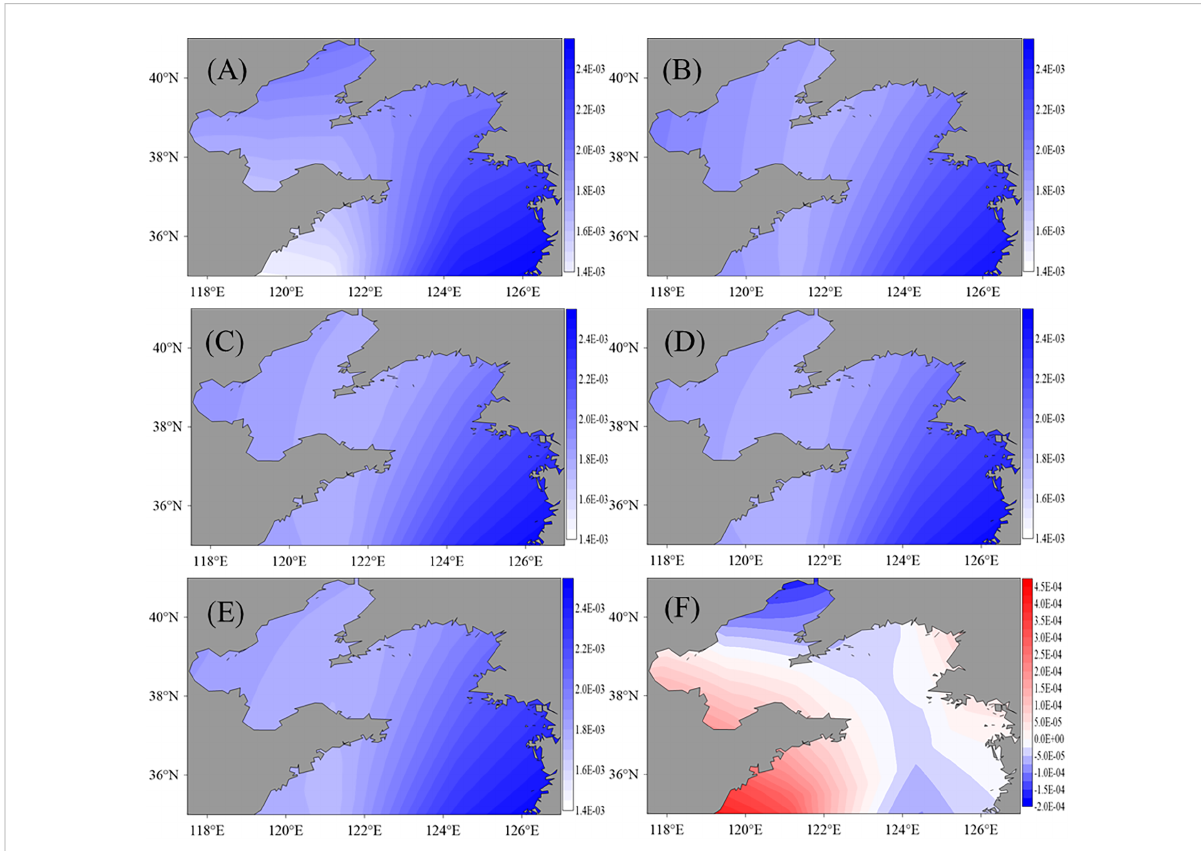
FIGURE 4 Distributions of the true BFCs (A) and that of experiment results with the 1°×1° (B) , 1/2°×1/2° (C) , 1/4°×1/4° (D) , and 1/12°×1/12° (E) observational grids. (F) is the difference between (E) and (A)